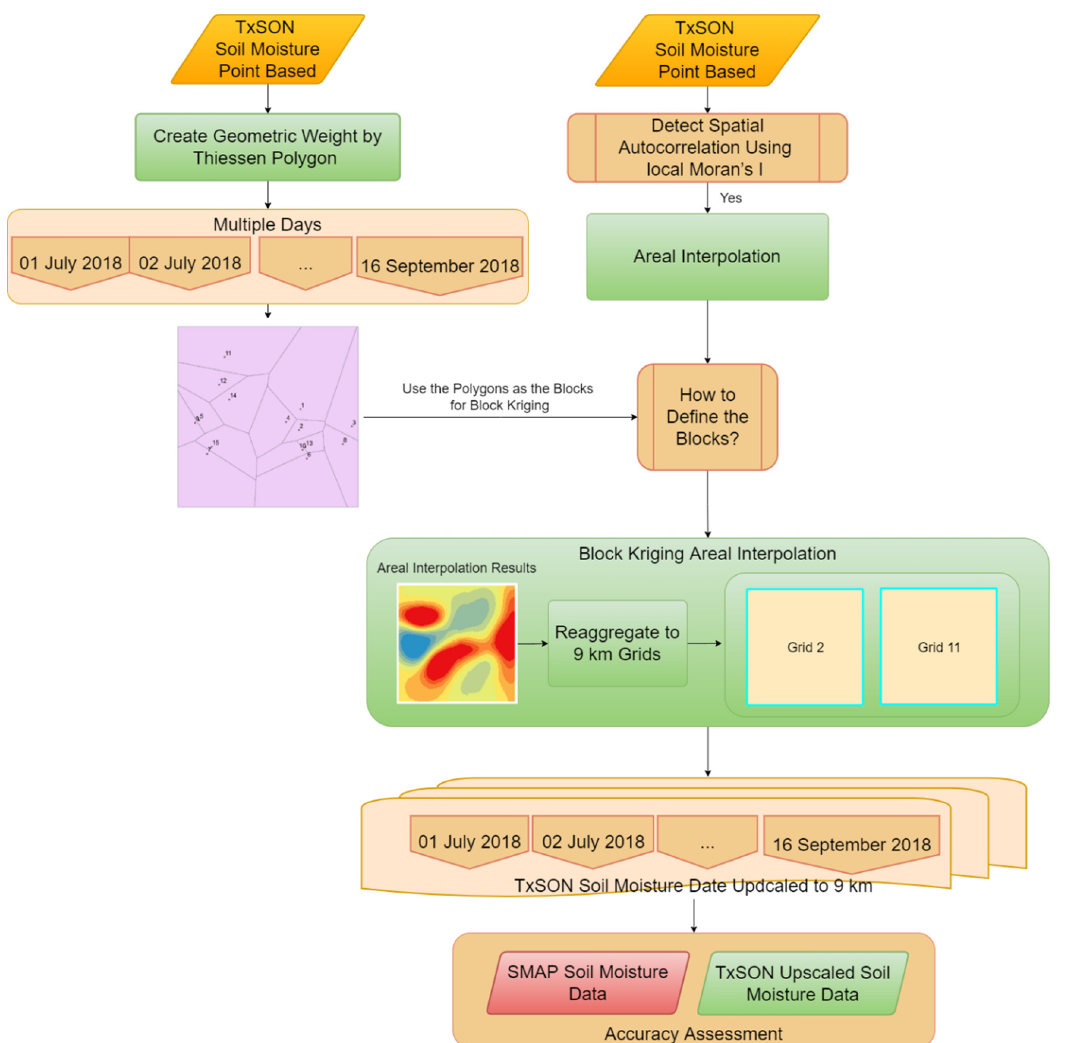
Figure 3. A schematic plot of the implementation of block kriging on top of the Thiessen polygon generated from the soil moisture stations (numbered 1–15). When spatial autocorrelation was detected, block kriging is used to remove the autocorrelation, using Thiessen polygons as blocks for the areal interpolation (blue indicates low soil moisture content and red indicates high soil moisture content), rather than point/pixel-based interpolation.